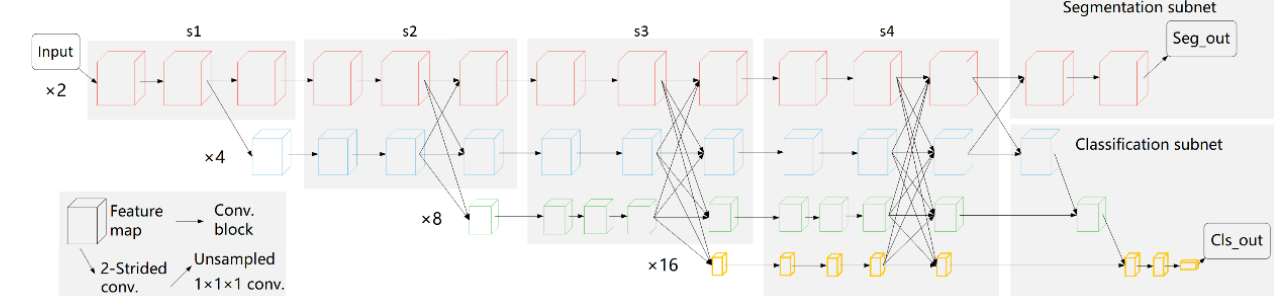
Figure 1. The network architecture of MT-HRNet-3d, composed of a simple stem, a main body, as well as the segmentation and classification subnets. The main body consists of four stages of parallel high-to-low resolution subnetworks with repeated information exchange across multi-resolution subnetworks (multi-scale fusion). ×n denotes the down-sampling ratio of the resolution representation to the input image, and the numbers of blocks of each stage module are [2,2,3,3] in [×2, ×4, ×8, ×16] resolution levels, respectively. In the segmentation subnet, only the highest resolution representations are concatenated for the medical lesion segmentation, while in the classification subnet, all the high-to-low resolution representations are aggregated for multi-class classification. Seg_out and Cls_out are the outputs of two subnets. In this study, the lesion volume reconstructed from Seg_out result was used as an input of machine learning algorithm of severity classification.